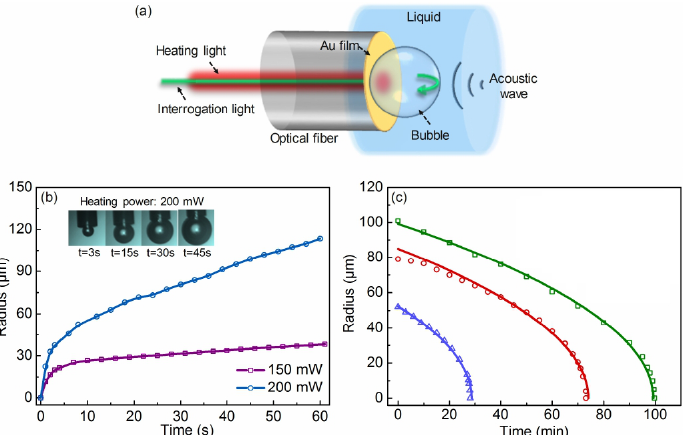
Figure 17. ( a ) Schematic view of a bubble-on-fibre system for detecting acoustic pressure waves. The system consists of a conventional single-mode optical fibre used to deliver both heating and interrogation light beams to a bubble. A thin gold film is used to absorb light and produce Joule heat needed to generate a microbubble. ( b ) Temporal microbubble growth at heating light powers of 150 and 200 mW. The inset shows snapshots of a growing microbubble. ( c ) Bubble decay after the heating light was turned off. The green curve with squares shows the behaviour of a bubble that reached radius of 101 µ m. The other two curves correspond to smaller bubbles with radii of 79 µ m and 52 µ m, respectively. Reproduced from [212]. Copyright 2018 Optical Society of America under the terms of the OSA Open Access Publishing